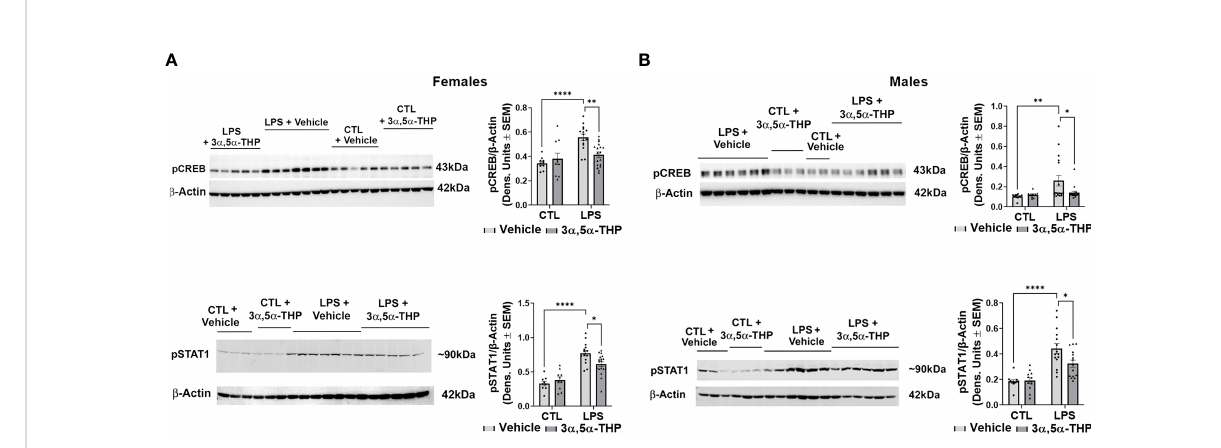
FIGURE 3 Allopregnanolone (3 a ,5 a -THP) inhibits LPS-induced activation of MyD88-dependent TLR4 pro-in fl ammatory signal and does not target non- activated TLR4 signal in human monocyte-derived macrophages (hMDM) from both female and male donors. hMDM cultures were treated with LPS (1µg/ml; 24 h) with or without allopregnanolone (1µM; 24 h). Representative western blot images and summary data of densitometric scatter dot plots show the levels of pCREB and pSTAT1 in females (A) and males (B) . Each data point represents an individual hMDM culture (n ≥ 12 cultures from 3 female (A) or 3 male (B) donors/grp). b -Actin was used as protein loading control. LPS caused a signi fi cant increase in the levels of pCREB (~40% and ~60% in MDM from female (A) and male (B) donors, respectively) and pSTAT1 (~60% in hMDM from both female (A) and male (B) donors) relative to vehicle control (CTL). The increases of pCREB were completely inhibited by allopregnanolone in hMDM from both female (A) and male (B) donors. The increases of pSTAT1 were partially inhibited by allopregnanolone (~35% and ~45% inhibition in hMDM from female (A) and male (B) donors, respectively). Allopregnanolone did not change the levels of pCREB and pSTAT1 in hMDM that were not treated with the TLR4 agonist LPS (A, B), indicating that allopregnanolone speci fi cally targets the activated TLR4 signal. Two-way